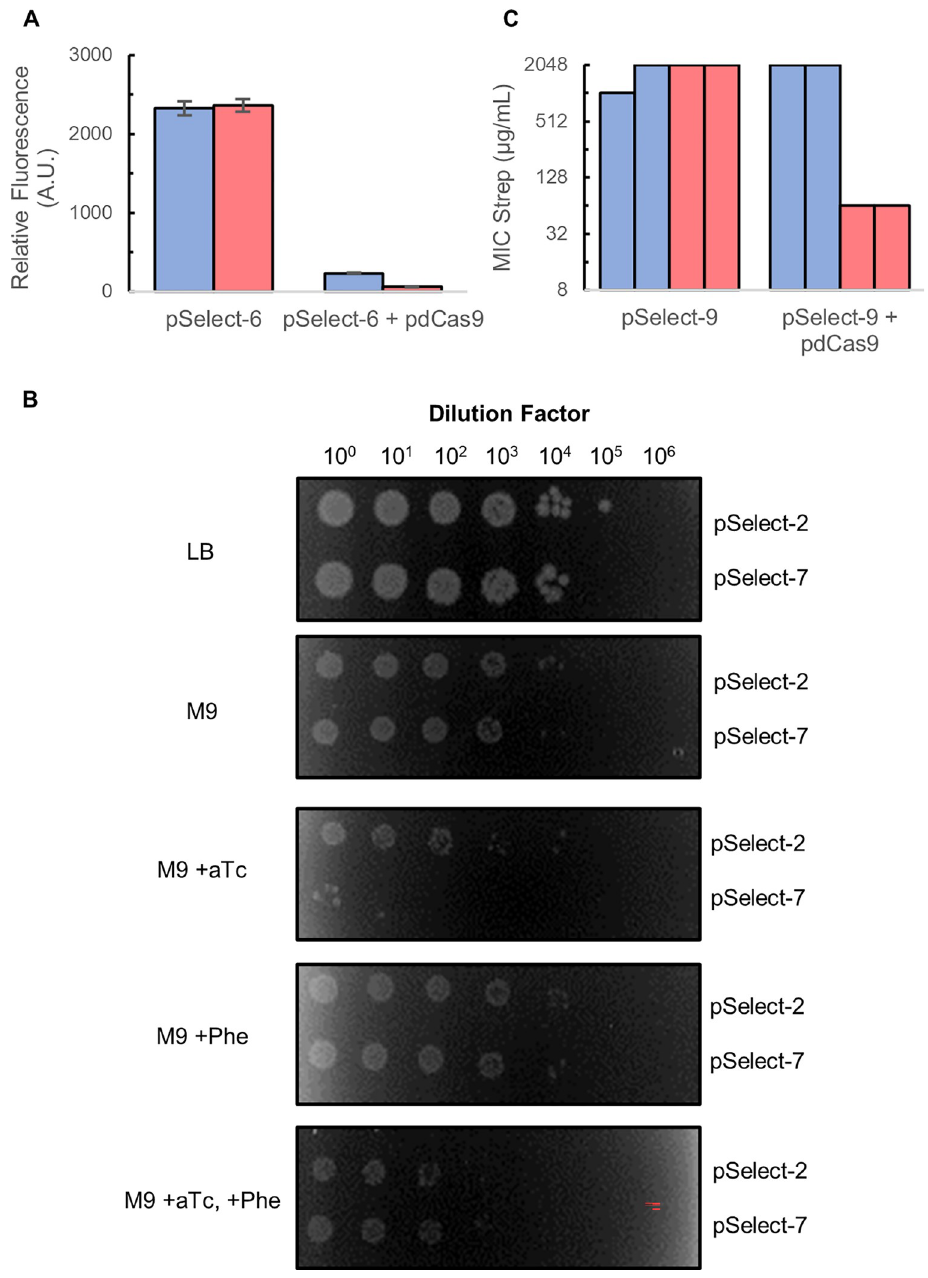
Fig 2. Negative selection system for dCas9 activity. (A) Relative GFP fluorescence after six hours of growth of MG1655 nfsA :: (mRFP , sfGFP , Kan R ) cells [3]. Each experiment was performed in the absence (left bars) and presence (right bars) of the pdCas9 plasmid and in the absence (blue bars) and presence (red bars) 2 nM aTc. Error bars represent the standard deviation (n = 3). (B) MG1655 cells spotted on LB-agar and M9-agar. The media along with any supplements it contained is indicated along the column to the left of the plates. aTc was added to a concentration of 2 nM, and phenylalanine was added to a concentration of 10 μ g/mL. The selection plasmid present is indicated along the column to the right side of the plates and the dilution factor of each spot is indicated above the plates. (C) Replica minimum inhibitory concentration assays. Each assay was performed twice. Each experiment was performed in the absence (left bars) and presence (right bars) of the pdCas9 plasmid and in the absence (blue bars) and presence (red bars) 2 nM aTc.